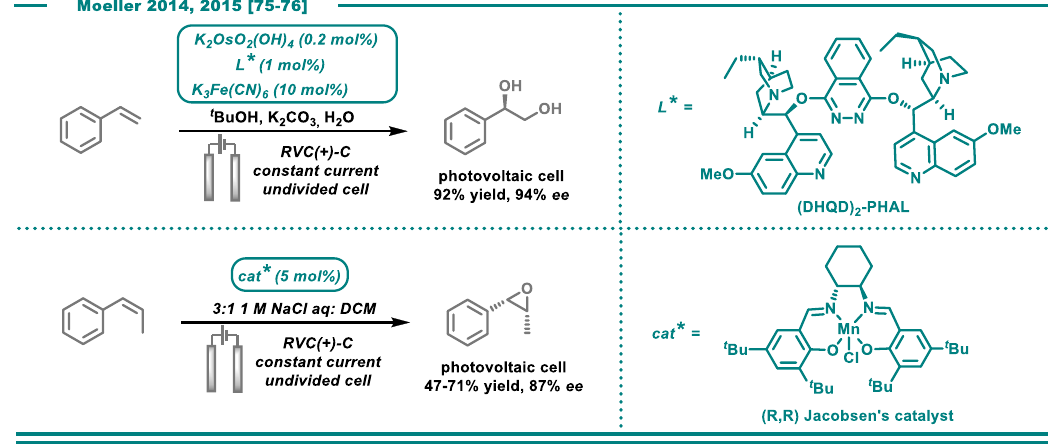
Figure 3. Principle for indirect oxidative electrolysis using coupled redox